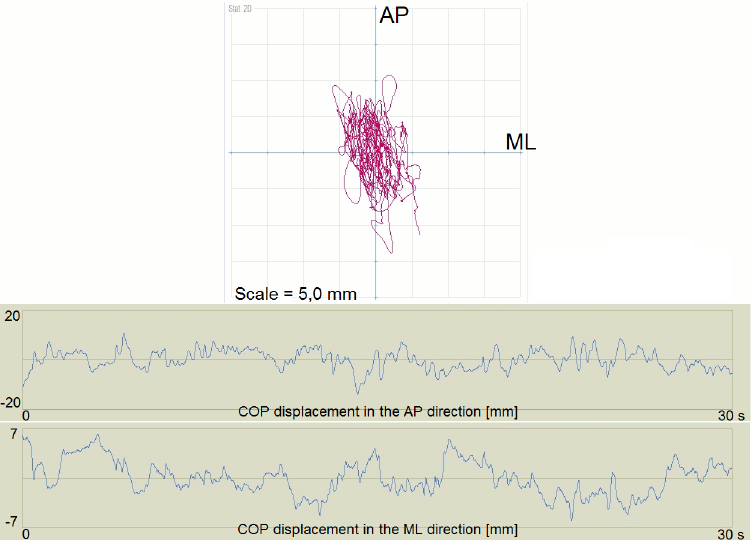
Fig 3. Example of the long path length for the COP. COP, Center of Foot Pressure; AP, anteroposterior direction; ML–mediolateral